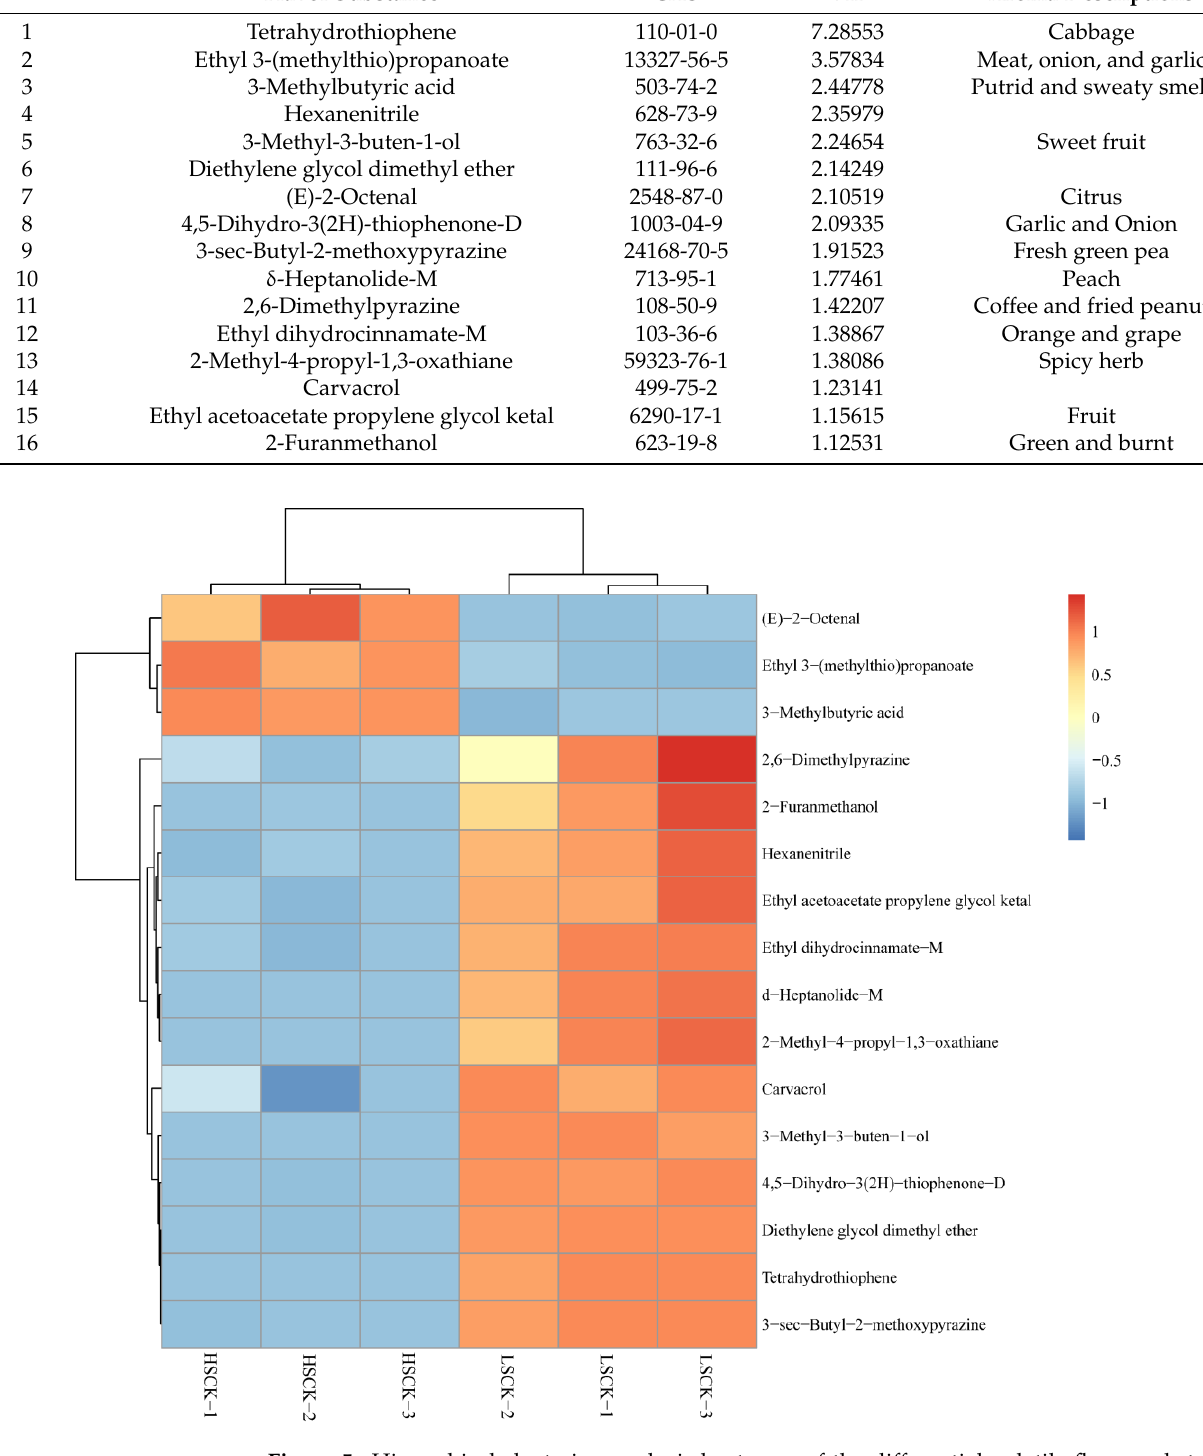
Figure 5. Hierarchical clustering analysis heat map of the differential volatile flavor substances between LSCK and HSCK.